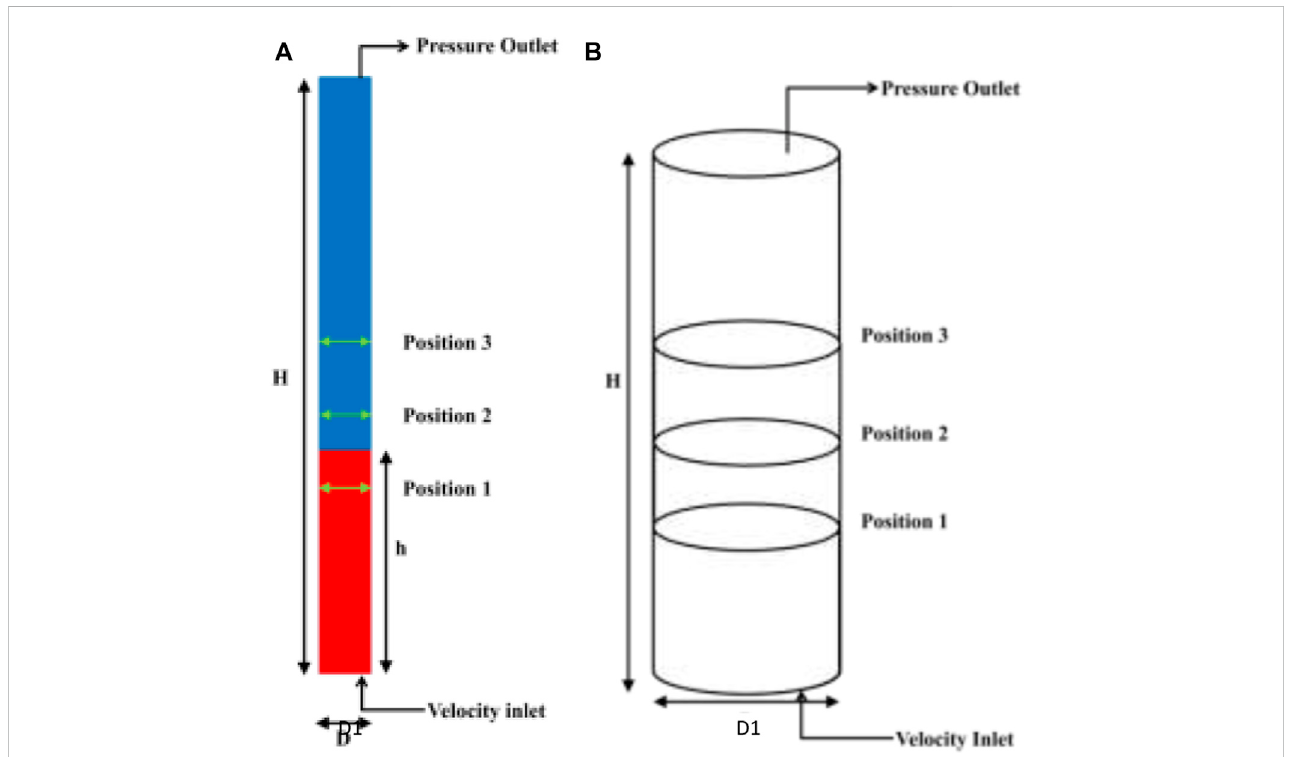
Schematic representation of fl uidized bed. (A) Schematic of 2D plane (from Ansys Fluent 18.1) showing bed height and axial positions. (B) 3D Schematic with representation (current schematic assumes 0.335 m initial bed